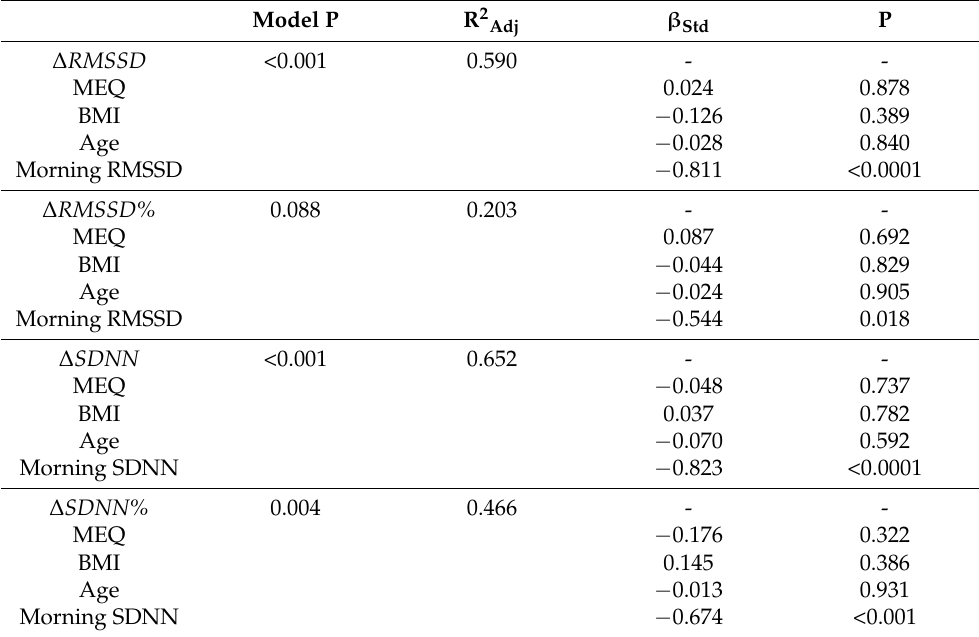
Table 2. Results of multiple linear regression models for absolute and relative changes in heart rate variability parameters. Model P R 2